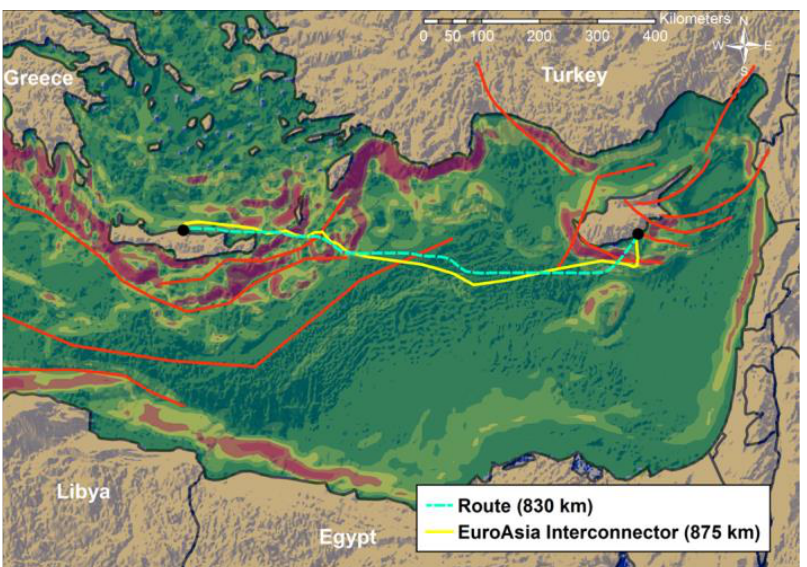
Seismic Fault Zones